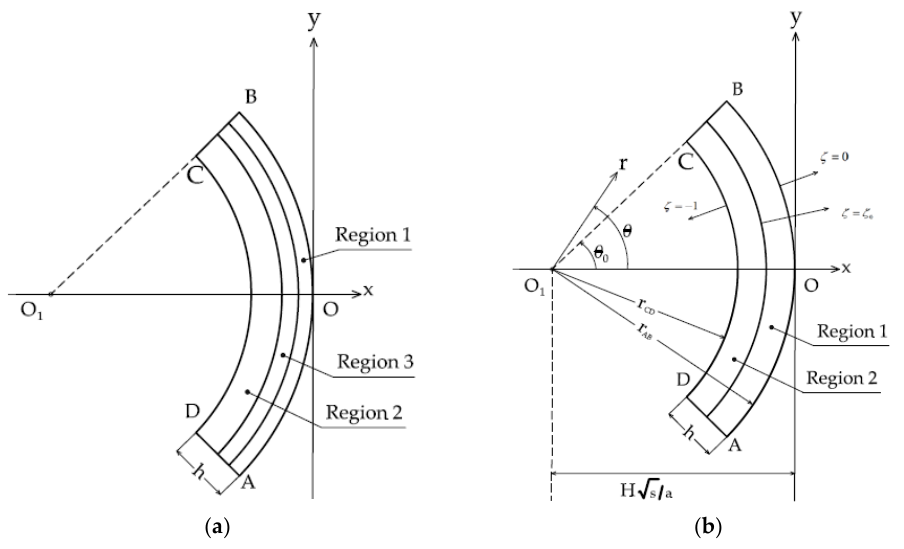
Figure 2. Structure of the solutions: ( a ) general solution; and ( b ) ideal flow solution.